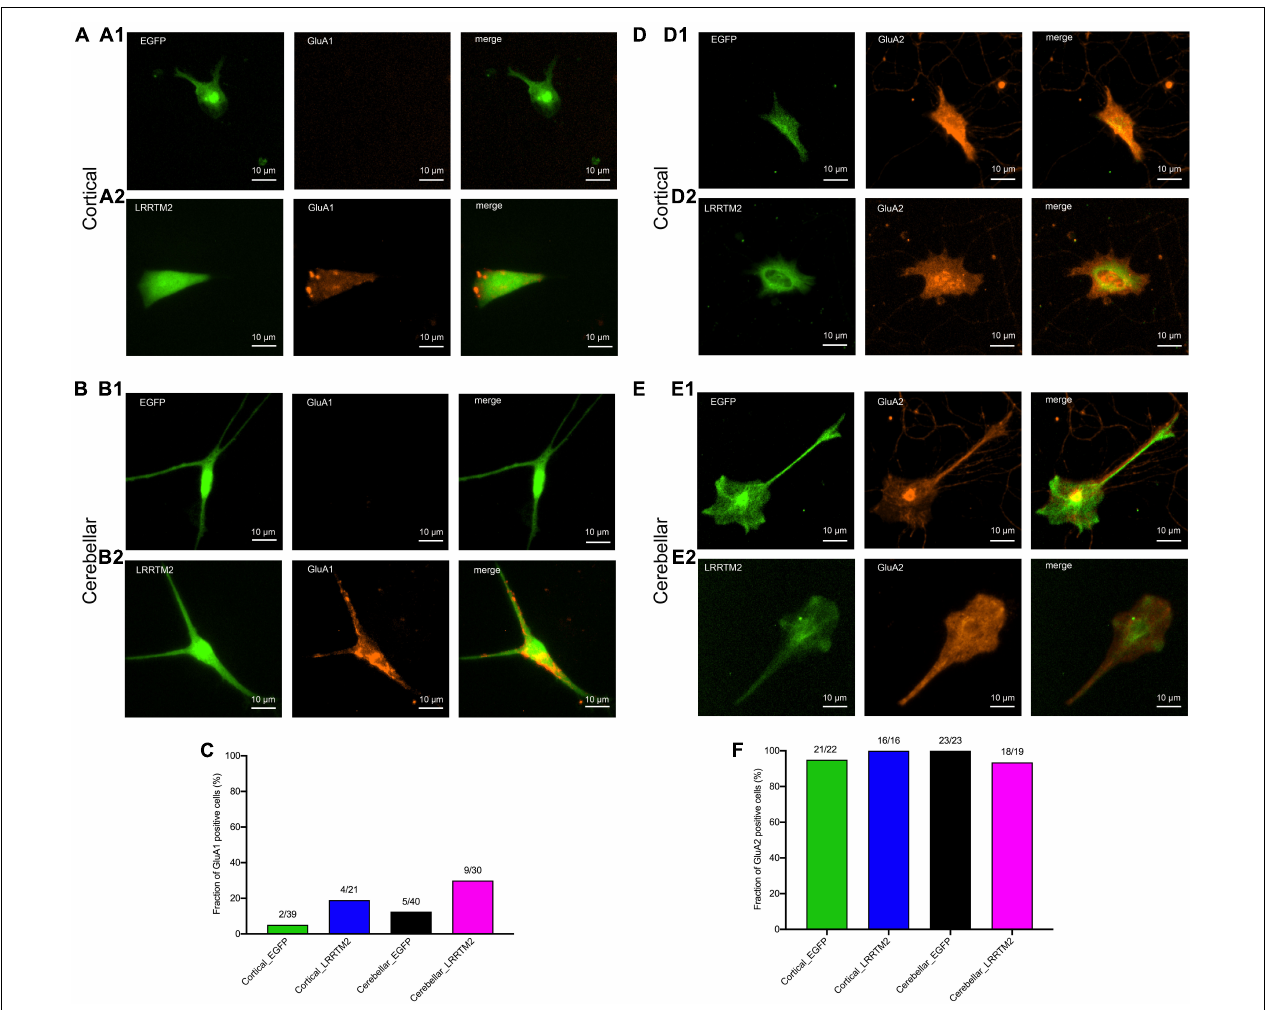
FIGURE 5 | Effects of LRRTM2 expression on AMPA receptor subunit GluA1 and GluA2 expression in immature cortical and cerebellar astrocytes contacted by explant axons. (A,B) Fluorescence images of transfected astrocytes (EGFP (control) and LRRTM2 + EGFP, green) and immunostainings for GluA1 (red) in immature cortical astrocytes (A1,A2) and in cerebellar astrocytes (B1,B2) . Scale bars: 10 µ m. (C) Quantification of the fraction of GluA1 positive astrocytes. (D,E) Fluorescence images of transfected astrocytes (EGFP (control) and LRRTM2 + EGFP, green) and immunostainings for GluA2 (red) in immature cortical astrocytes (D1,D2) and in cerebellar astrocytes (E1,E2) . (F) Quantification of the fraction of GluA2 positive